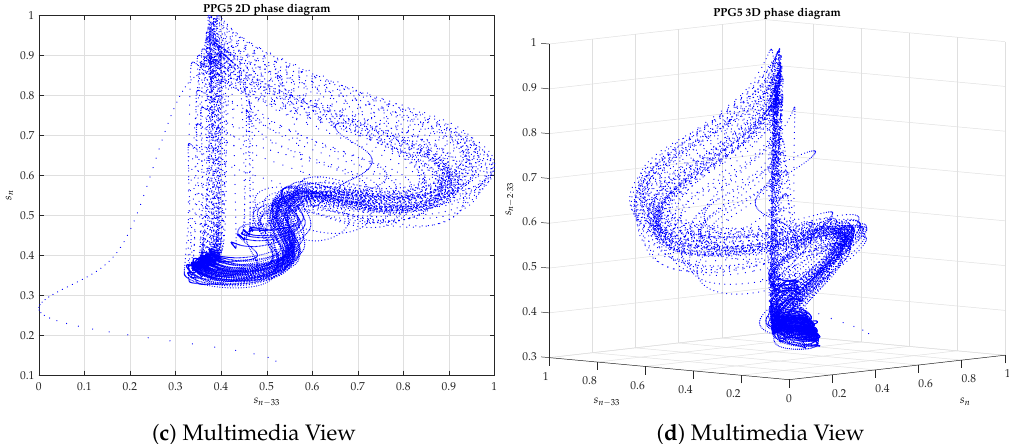
Figure A8. PPG signal of the healthy young Subject Number 5 (PPG5): ( a ) One minute PPG recorded signal. ( b ) PPG5 2D phase diagram with τ = 1. ( c ) PPG5 2D phase diagram with τ = 33, according to Table 1. PPG5 video clip of the evolution of phase diagram from τ = 1 to τ = 150 in 2D. ( d ) PPG5 3D phase diagram with τ = 33. PPG5 video clip of the evolution of phase diagram from τ = 1 to τ = 150 in